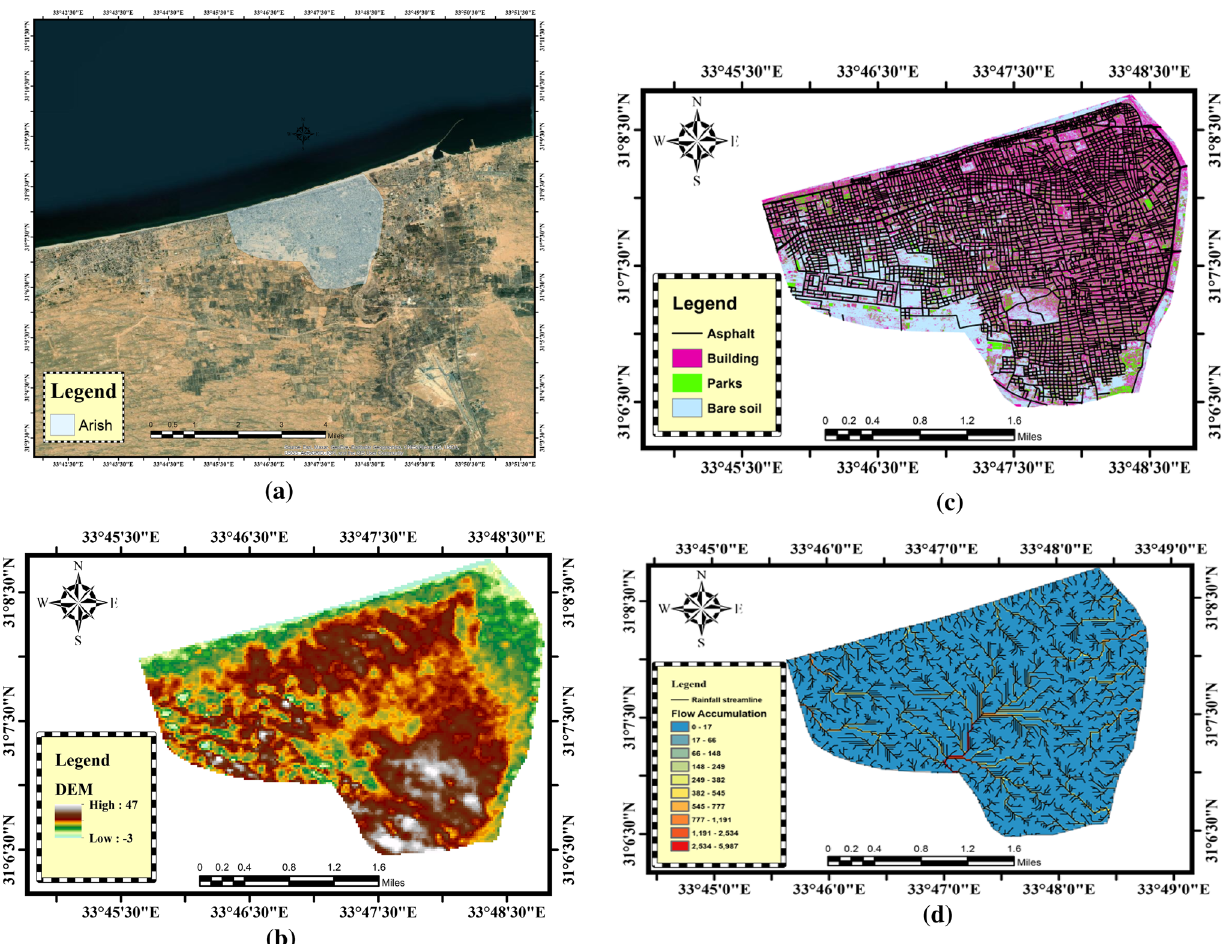
Fig. 8 a Google earth map, b digital elevation model, and c land-use map, and d flow accumulation map for 1st Department Region in Al-Arish city (Gabr et al. 2022a)